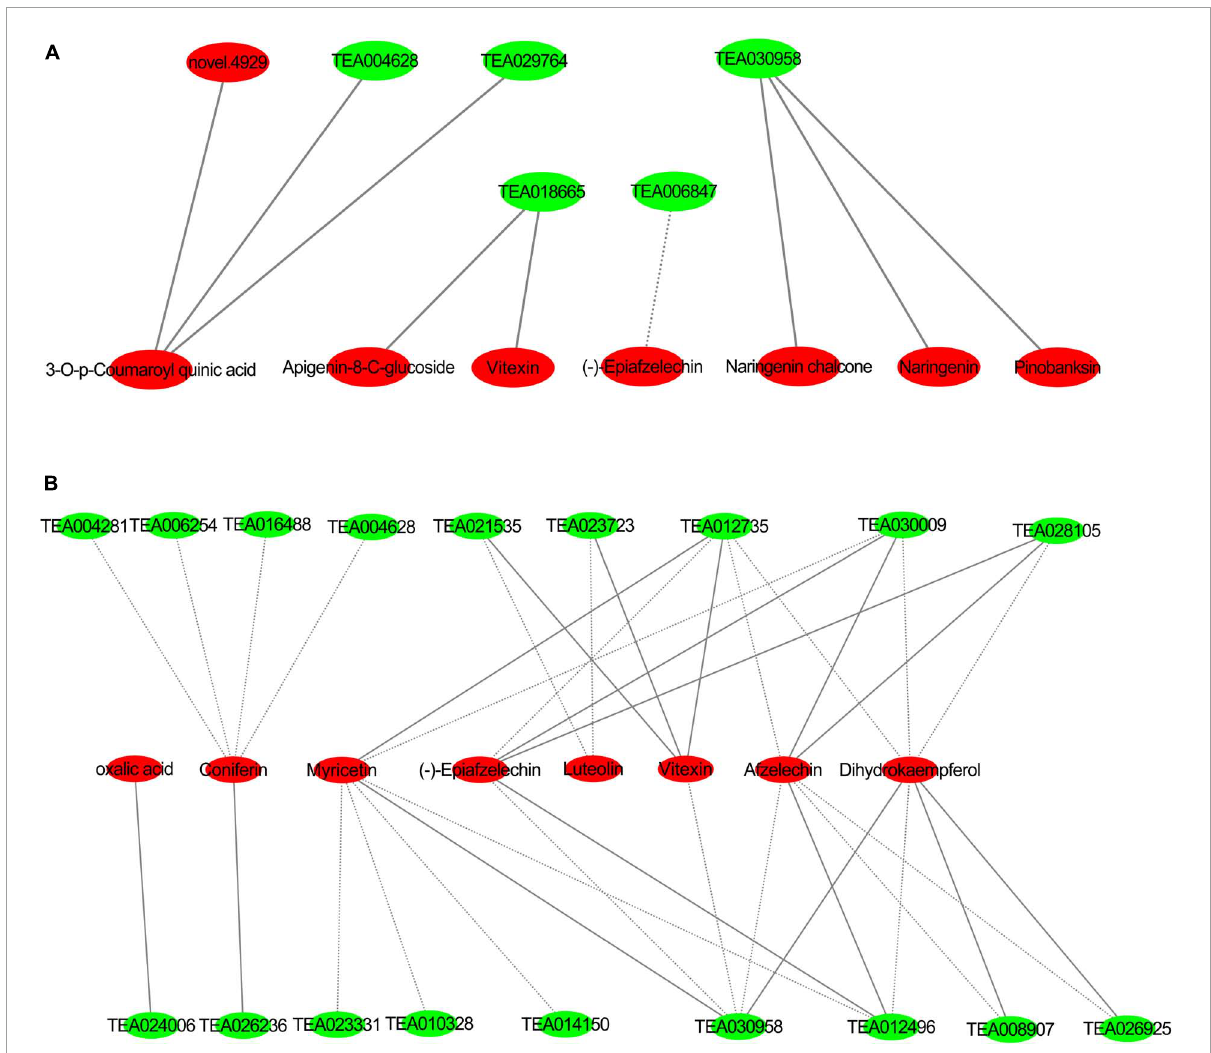
FIGURE12 Interaction networks of differentially expressed genes and metabolites in phenylpropanoid pathway and flavonoid pathway (A) group JP; (B) group YX, red: differential metabolites, green: differentially expressed genes; solid line forward adjustment; dashed line reverse